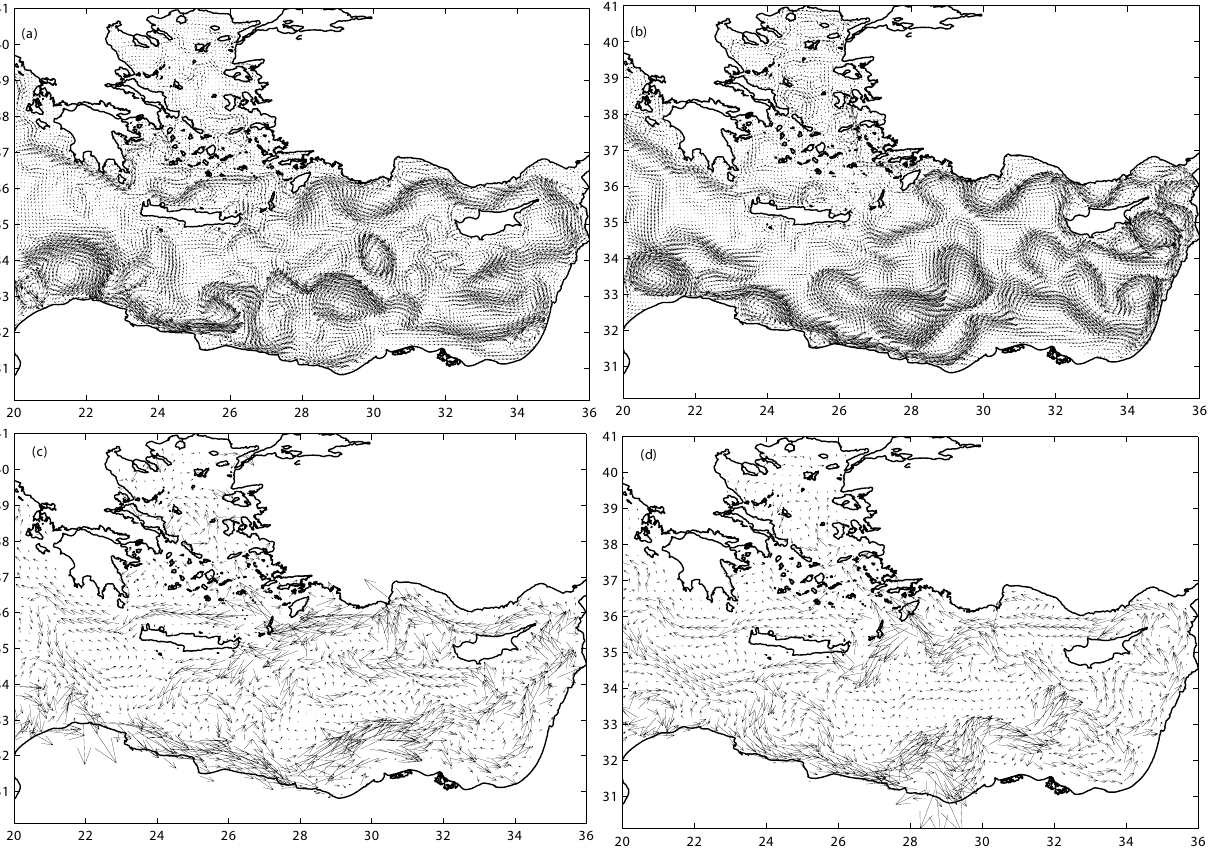
Fig. 11. (a) ALERMO’s subsurface velocity field (30m) during February, (b) as in Fig. 11a but for August (c) as in Fig. 11a but for the OGCM model (d) as in Fig. 11b but for the OGCM